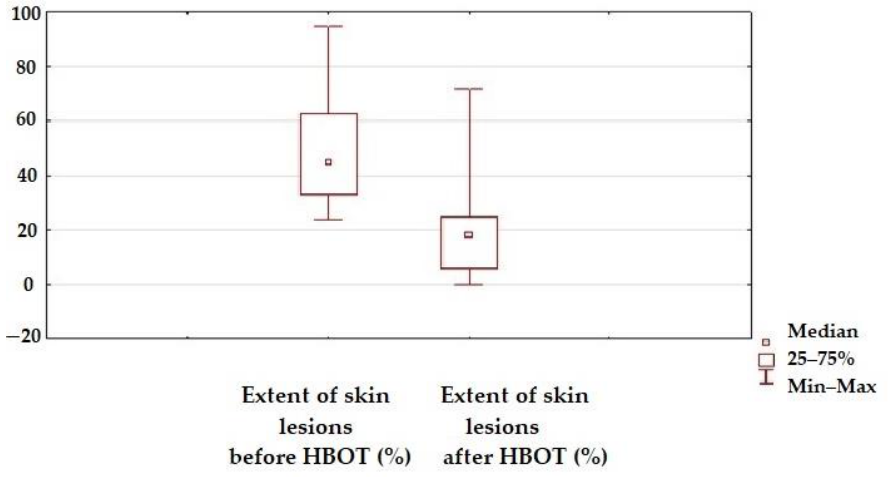
Figure 4. Extent of skin lesions before and after HBOT ( p < 0.05).